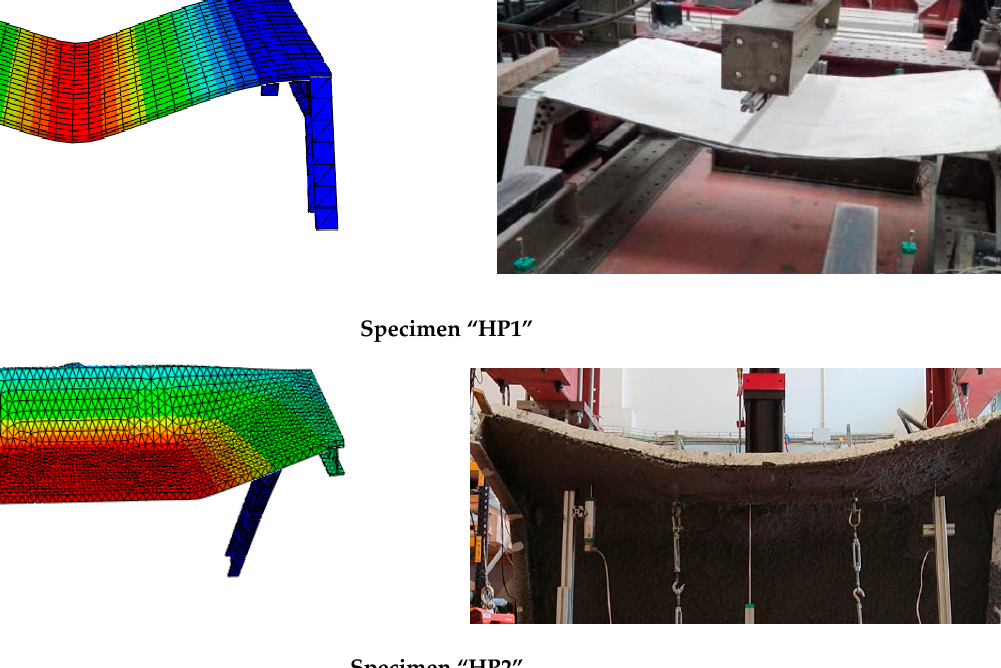
Figure 6. Failure mode in the tests.